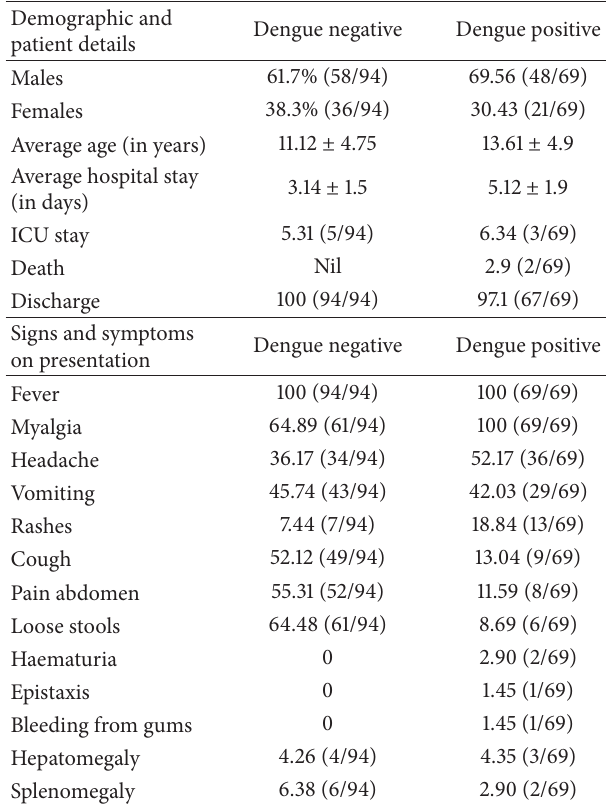
Table 1: Demographic and clinical symptoms of the children with dengue [percent (actual